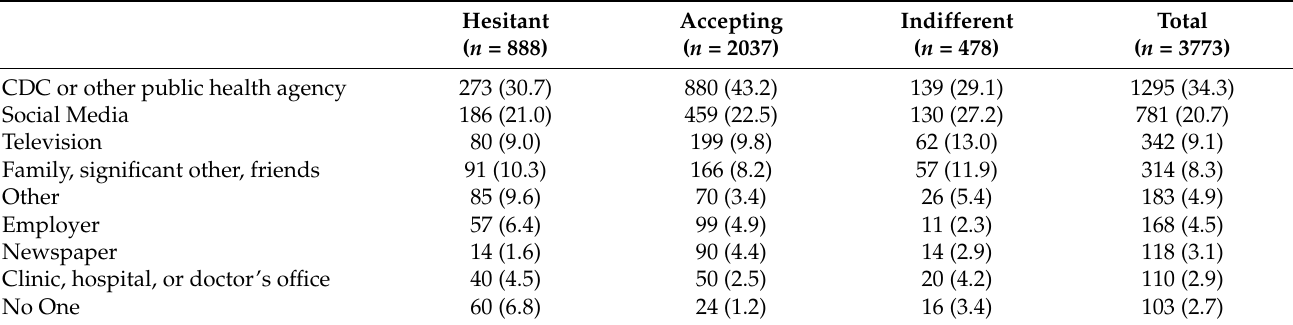
Table 5. Sources of information about health or COVID-19.